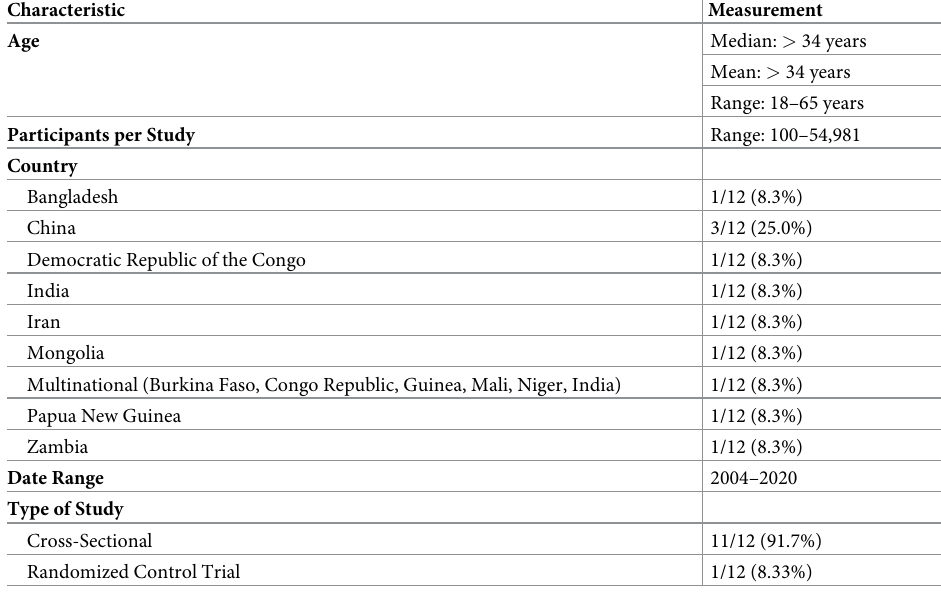
Table 1. Pooled characteristics of participants in included studies (N = 12 studies and N = 110,657 participants).